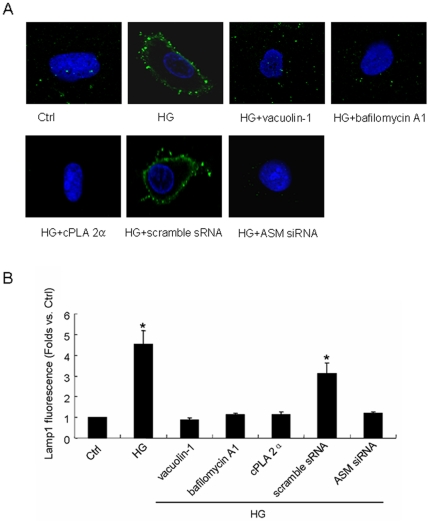
Effect of lysosomal inhibitors or acid sphingomyelinase (ASM) gene silencing on HG-induced movement of lamp1 to cellular membrane.A: representative images of lamp1 presentation on cellular membrane. The cells were cultured in normal glucose (5.6 mmol/l, Ctrl) or high glucose (22 mmol/l, HG) medium for 12 h with or without the pretreatment by vacuolin-1(10 µmol/l), bafilomycin A1 (100 nmol/l) or cPLA 2α (20 µmol/l) for 1 h or by the transfection of scramble small RNA (sRNA) or ASM small interfering RNA (siRNA). Then the lamp1 fluorescence on cellular membrane were detected and analyzed. B: summarized results of lamp 1 fluorescent abundance on cellular membrane in different groups. Values are means±SE; n = 5 batches of cells. * P<0.05 vs. Ctrl.